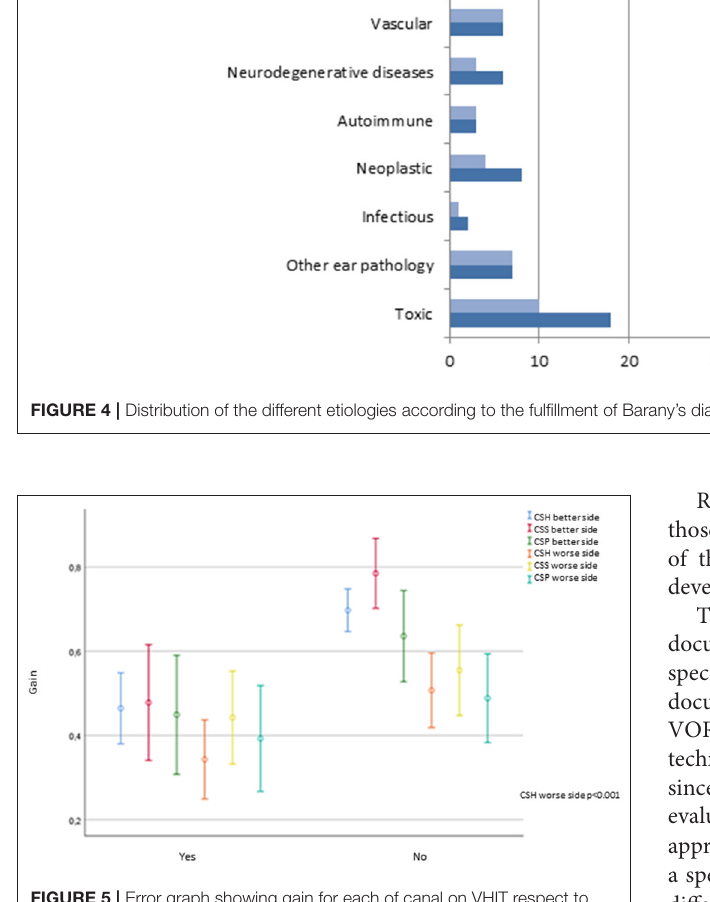
FIGURE 5 | Error graph showing gain for each of canal on VHIT respect to Barany’s